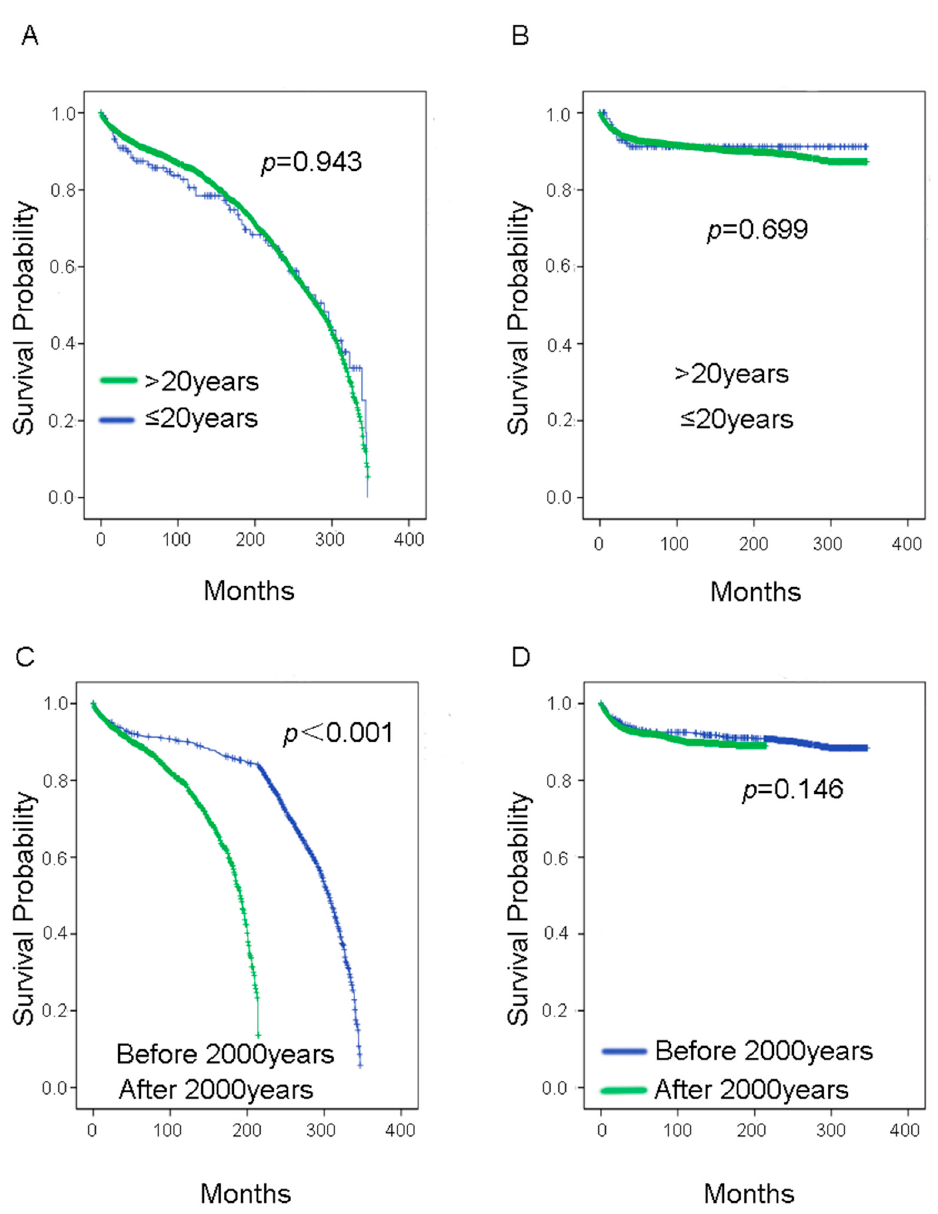
Figure 2. Survival analysis in younger bladder cancer patients at the age of diagnosis ( A ) OS, ( B ) CSS, and year of diagnosis ( C ) OS, ( D ) CSS. OS = overall survival; CSS = cancer-specific survival.